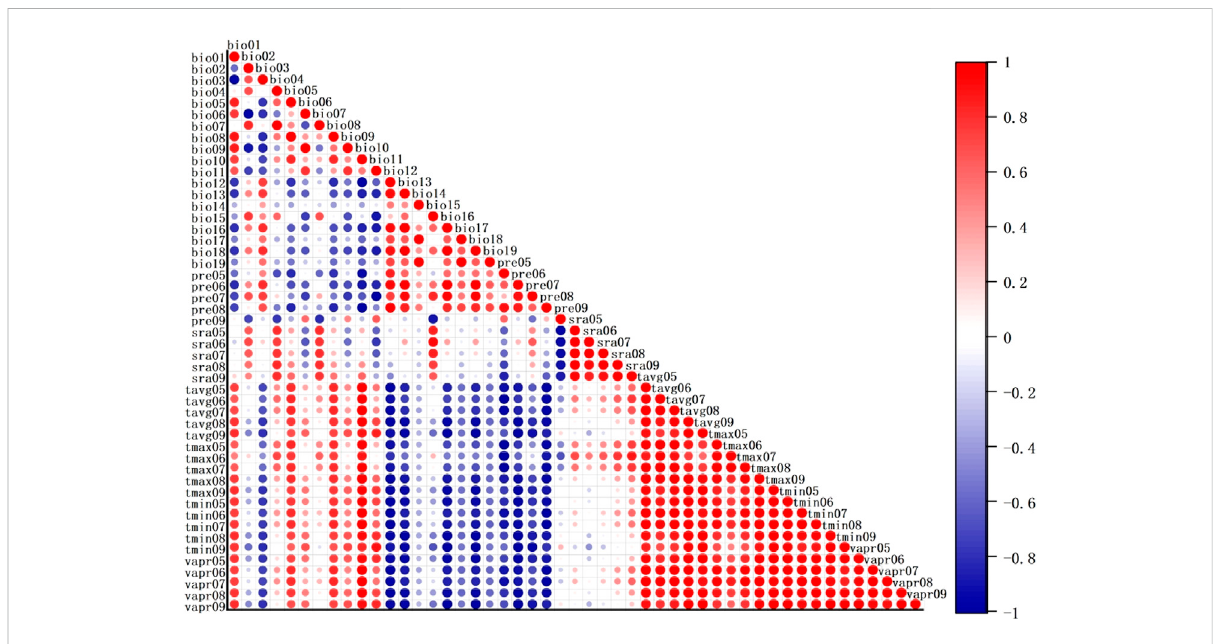
FIGURE 2 Results of correlation analysis of 49 environmental